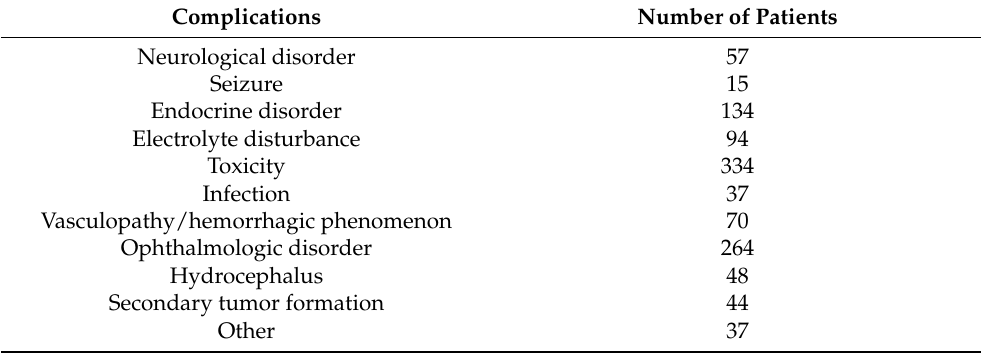
Table 2. The reported post-intervention complications and their frequency among the patients with